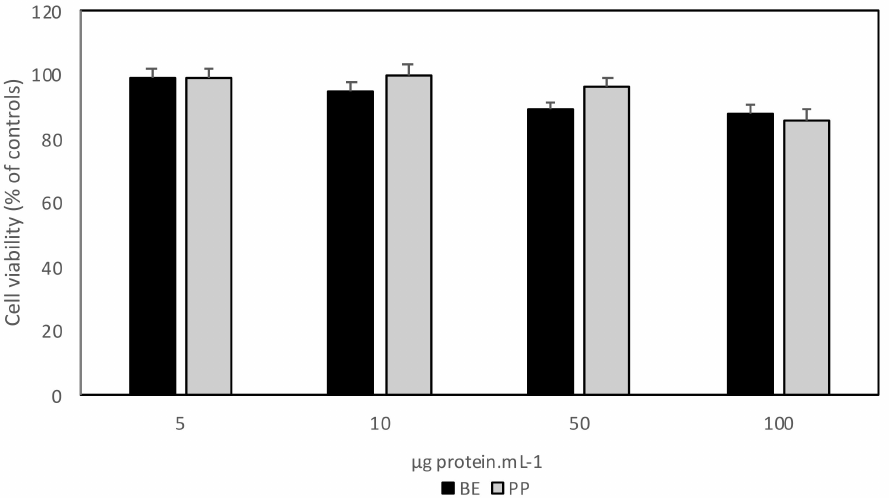
Figure 5. HT29 cell viability after a 48 h exposure to different concentrations of BE and PP fractions. Cells were grown for 48 h in the presence of 100, 50, 10, and 5 µ g protein · mL − 1 and stained with MTT. Values represented are the averages of three replicate experiments (n = 3) ± SD and are expressed as a percentage of the